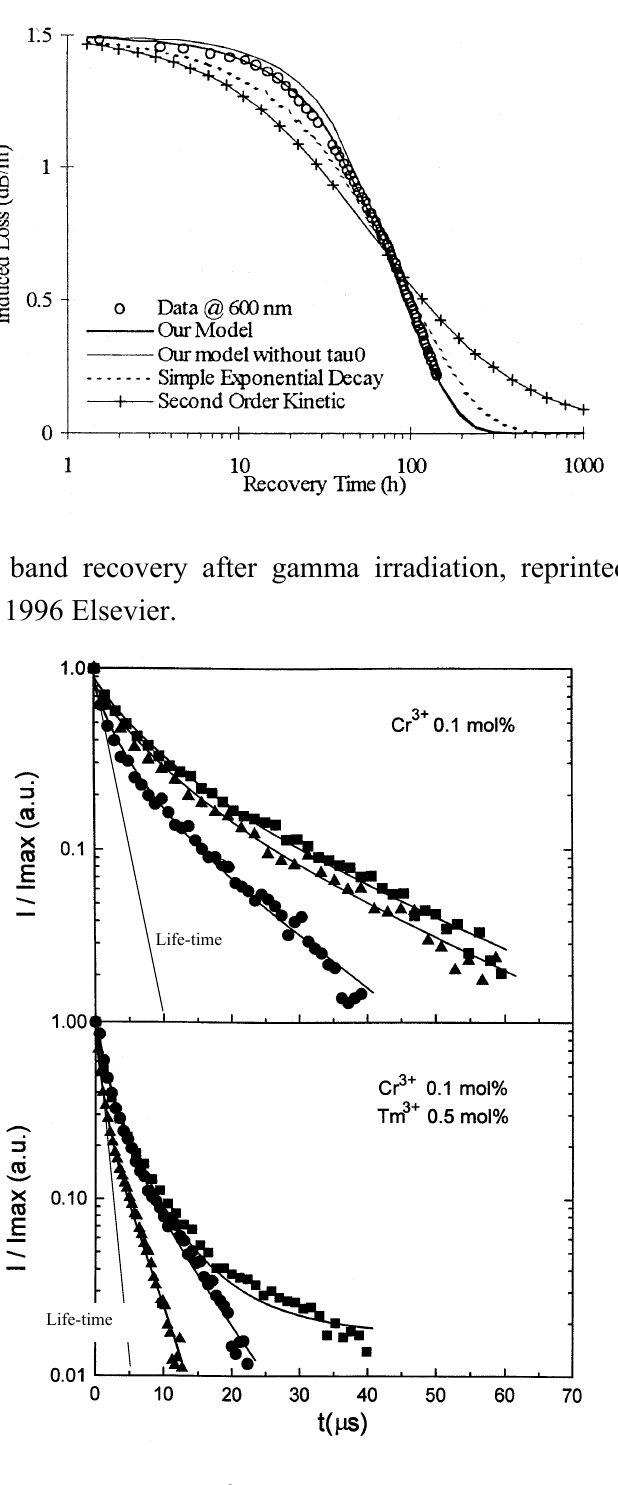
Figure 11. 4 T 2 → 4 A 2 emission from Cr 3+ (735 nm), reprinted with permission from [21]. Copyright 1997